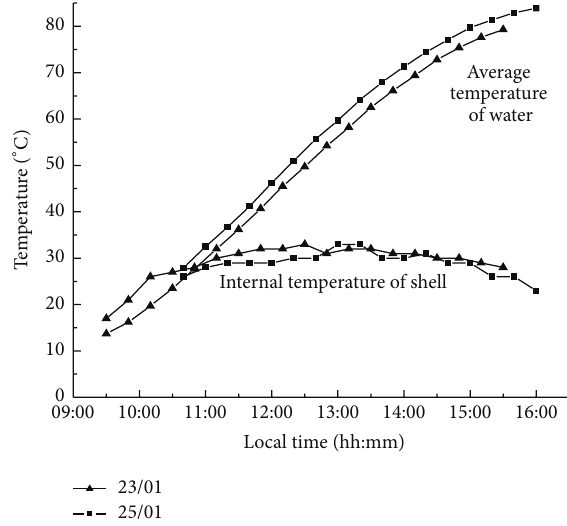
Figure 10: Change of water temperature and shell inside tempera- ture with